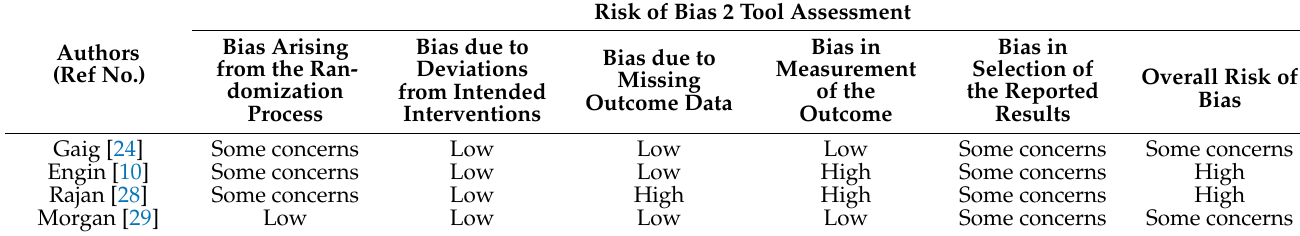
Table A2. Quality scores for the eligibility studies for adverse